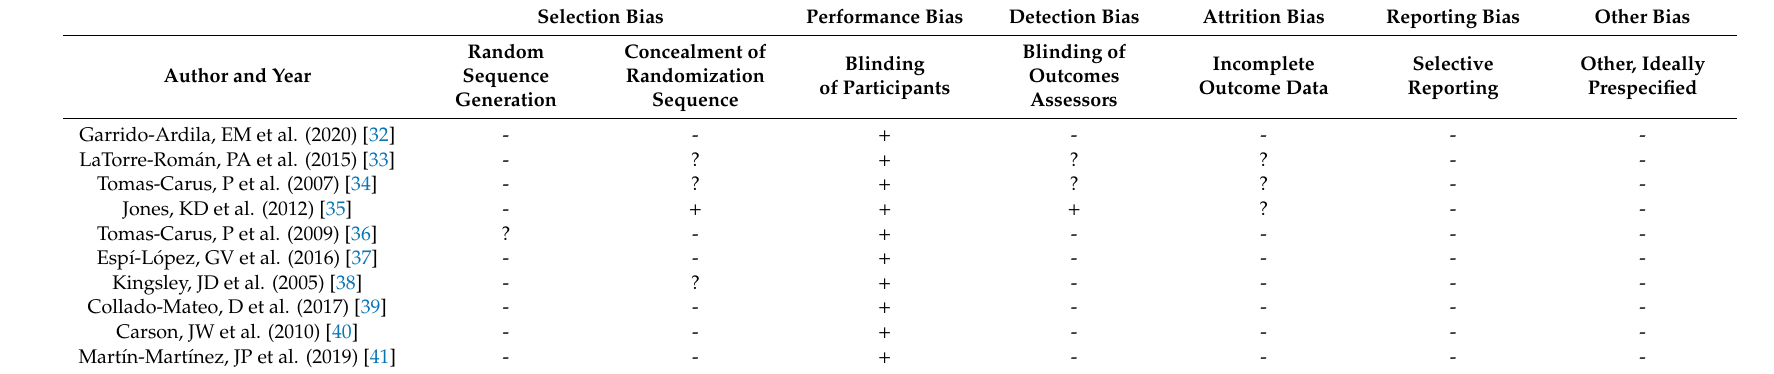
Table 3. Analysis of the Risk of Bias in the Included